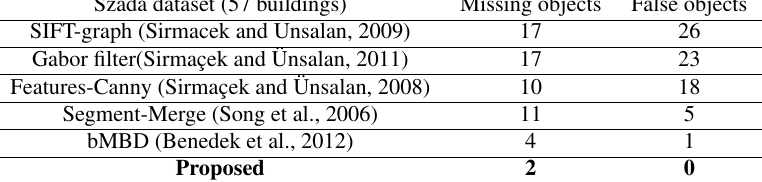
Table 1: Quantitative results for Szada